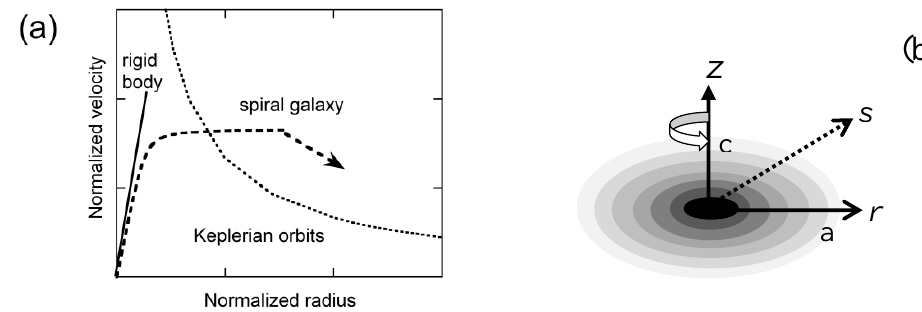
Figure 1. Schematics. (a) Graph comparing spin of a rigid top (with null central velocities) to Keplerian orbits (which have high central velocities) and to galactic RC, which show a gradation between these limiting cases. Mass components cannot be summed to produce RCs [9], as has been pursued in the Newtonian orbital model approach (e.g., [12–14]. (b) Nesting of similar, homogeneous homeoids to form a stratified oblate body, with axes labeled.